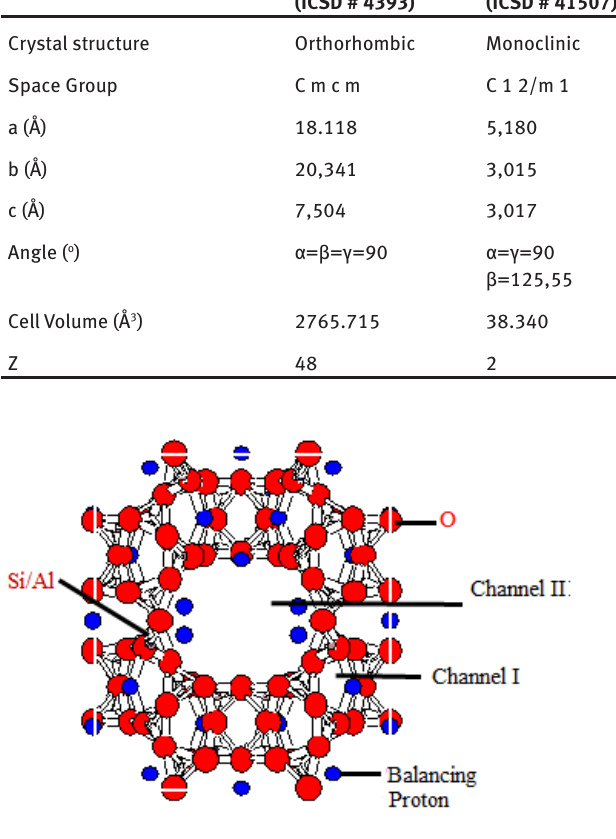
Figure 3: Modeling of MOR framework.